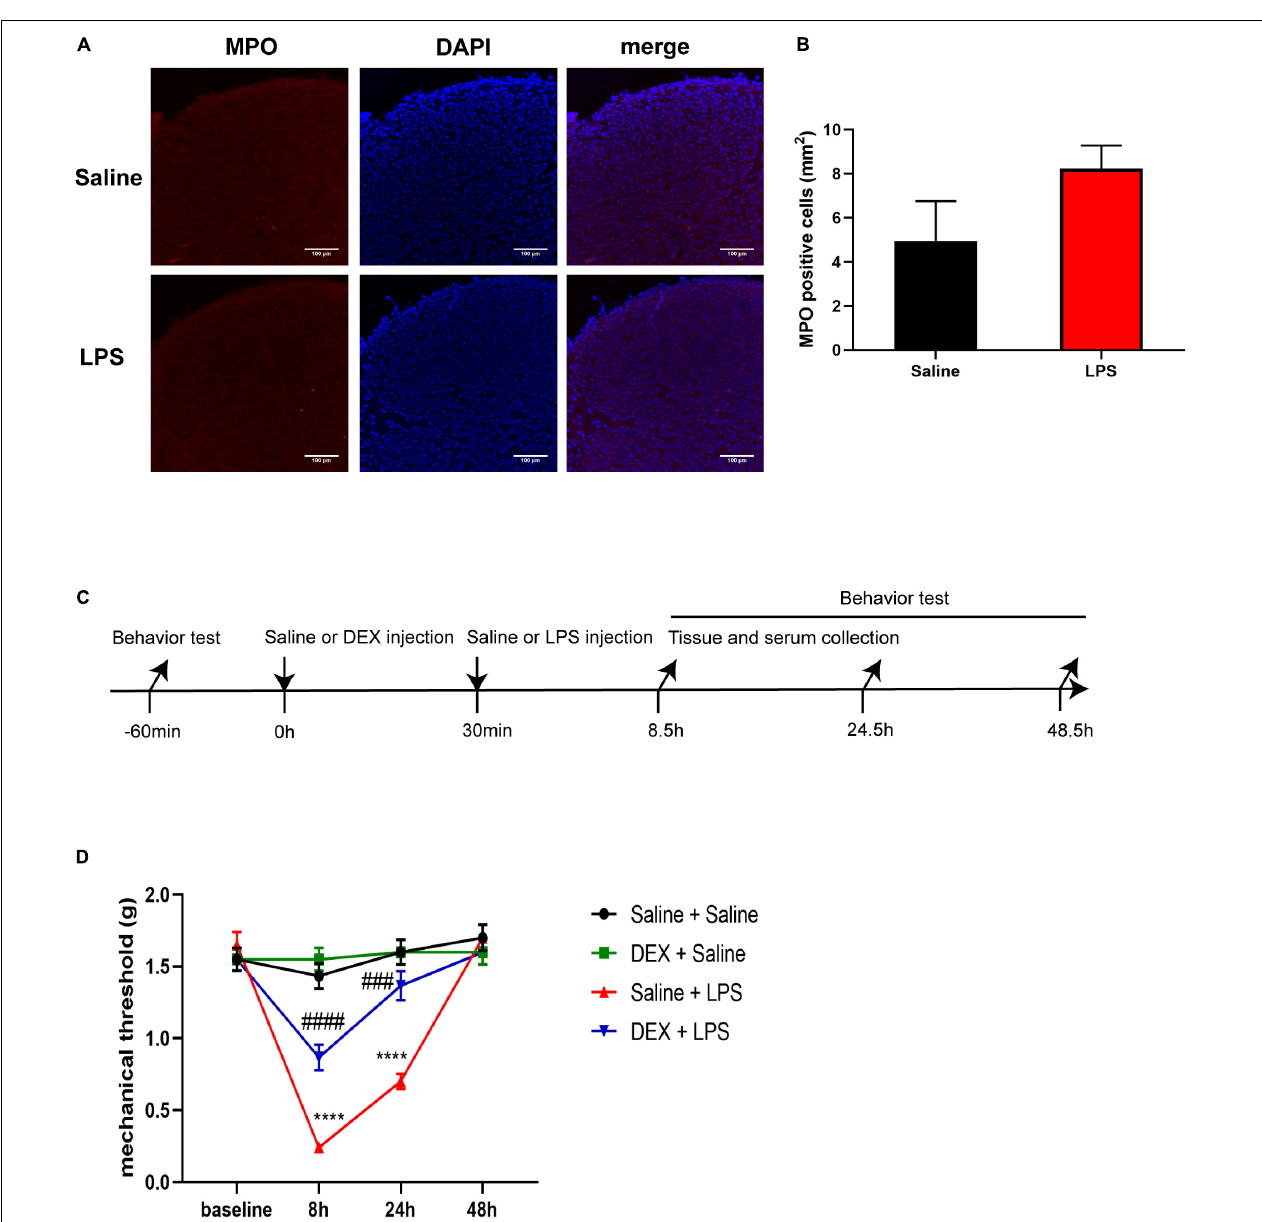
FIGURE 8 | DEX pretreatment attenuated LPS-induced mechanical hyperalgesia. (A) Representative photomicrographs of myeloperoxidase (MPO) immunostaining in the rat spinal cord dorsal horn 8 h after saline or LPS injection. Scale bars, 100 µ m. (B) Systemic LPS exposure did not induce obvious accumulation of MPO-positive cells 8 h after LPS injection. (C) Experimental design. P5-6 rat pups underwent intraperitoneal injection of saline or DEX. The baseline mechanical threshold was measured 1 h before saline or DEX injection. Thirty minutes after the injection, the rat pups were intraperitoneally injected with saline or LPS. Rat pups underwent a nociceptive behavior test 8, 24, and 48 h after LPS injection, or were sacrificed for mRNA analyses and ELISA 8 h after LPS injection. (D) Mechanical threshold was decreased in rats 8 and 24 h after LPS injection, and DEX significantly alleviated LPS-induced mechanical hyperalgesia. Results of panel (B) are expressed as the mean ± SEM, n = 4 animals for each group, and were analyzed by unpaired t -test. Results of panel (D) are expressed as the mean ± SEM, n = 12 animals for each group and were analyzed by two-way repeated-measures ANOVA followed by Bonferroni’s multiple comparisons test. **** P < 0.0001 Saline + LPS group vs. Saline + Saline group. ### P < 0.001, #### P < 0.0001 DEX + LPS group vs. Saline + LPS